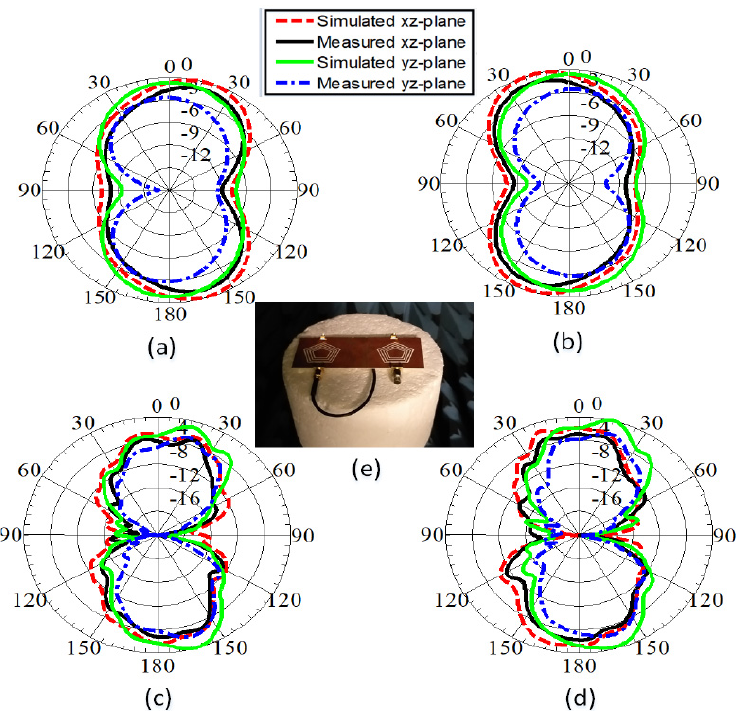
Figure 12. Measured and simulated gain patterns: ( a ) Ant − 1 at 1.9 GHz, ( b ) Ant − 2 at 1.9 GHz, ( c ) Ant − 1 at 4.2 GHz, ( d ) Ant − 2 at 4.2 GHz, ( e ) Measurement η Table 2. ECC, ( % ), peak gain (PG), and diversity gain (DG) .